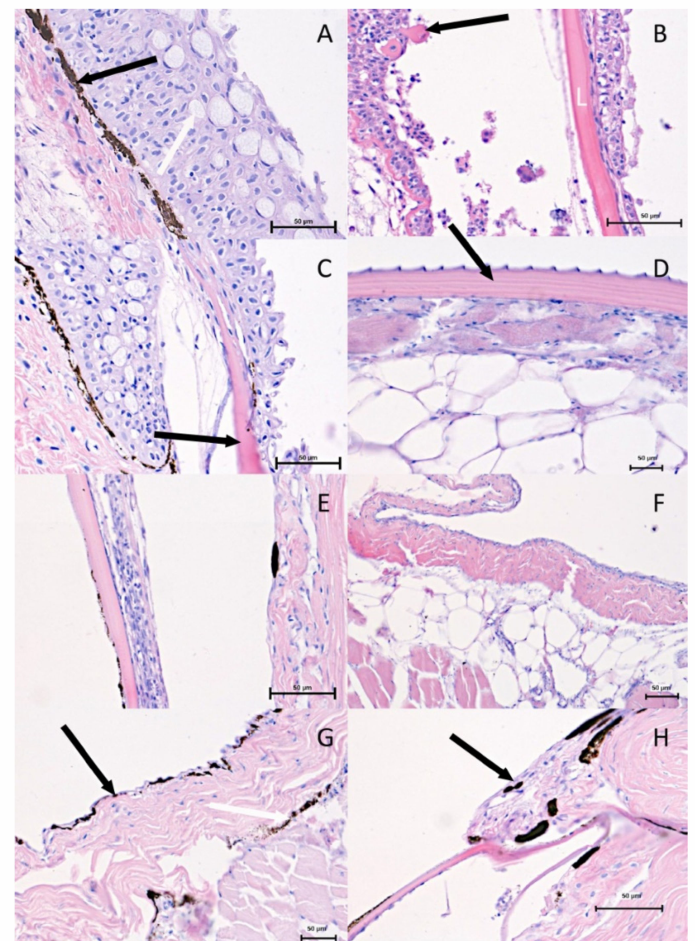
Figure 2. Skin in the spring-summer period: A . The dorsal area; numerous melanophores are visible (arrow) directly under the basal layer of the epithelium. The surface layer contains numerous mucus cells (white arrow). H-E 400x. B . The ventral area; the epithelium visible on a scale (L) with single, developing forms of mucus cells. No melanophores within this area. Clusters of fat cells and alarm cells (arrow) visible under poorly developed connective tissue. H-E 400x. C . The dorsal area; the epithelium covering a scale (arrow) with drastically reduced number of layers. No melanophores within this area. H-E 400x. The skin in the autumn-winter period: D . The ventral area; the scale (arrow) not covered with the epithelium. The scale adheres directly to the connective tissue underlined with adipose tissue. H-E 400x. E . The dorsal area; delaminated stratified epithelium with small mucus cells covered by a scale. H-E 200x. F . The ventral area; the skin is covered with the epithelium with few cell layers without mucus cells. Well-developed dermis made of collagen fibres. Clusters of yellow adipose tissue in the hypodermis between the dermis and muscles. H-E 400x. G . The dorsal area; strong local reduction of epithelium (arrow) seemingly in contact with melanophores. The second melanophore layer on the border of dermis and hypodermis (white arrow). H-E 200x. H . The dorsal area; strong local reduction of epithelium (arrow) near a scale. Melanophores remain in the skin fold accompanying the scale. H-E